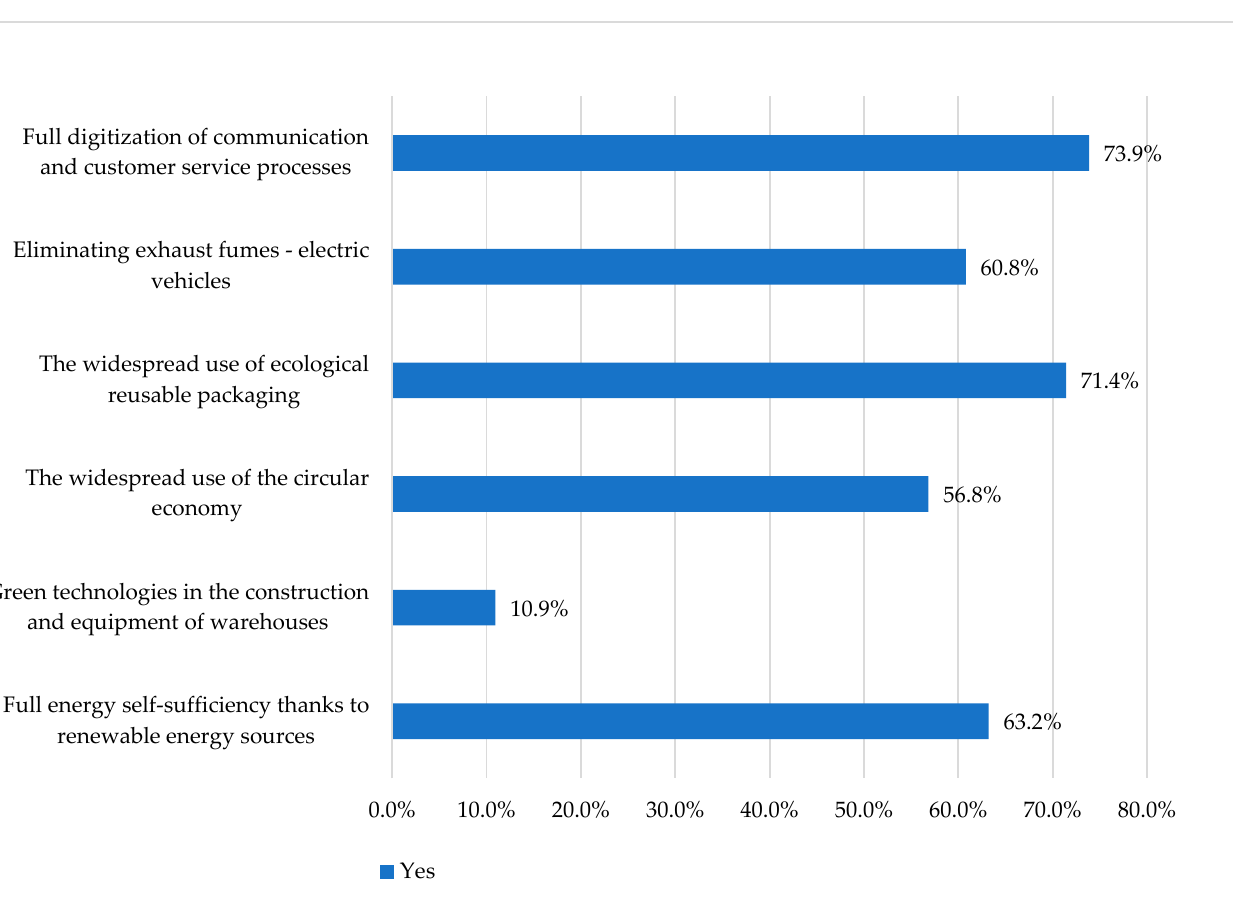
Figure 6. Technological solutions consistent with the concept of sustainable development that will be used by companies offering logistics services in the nearest future.